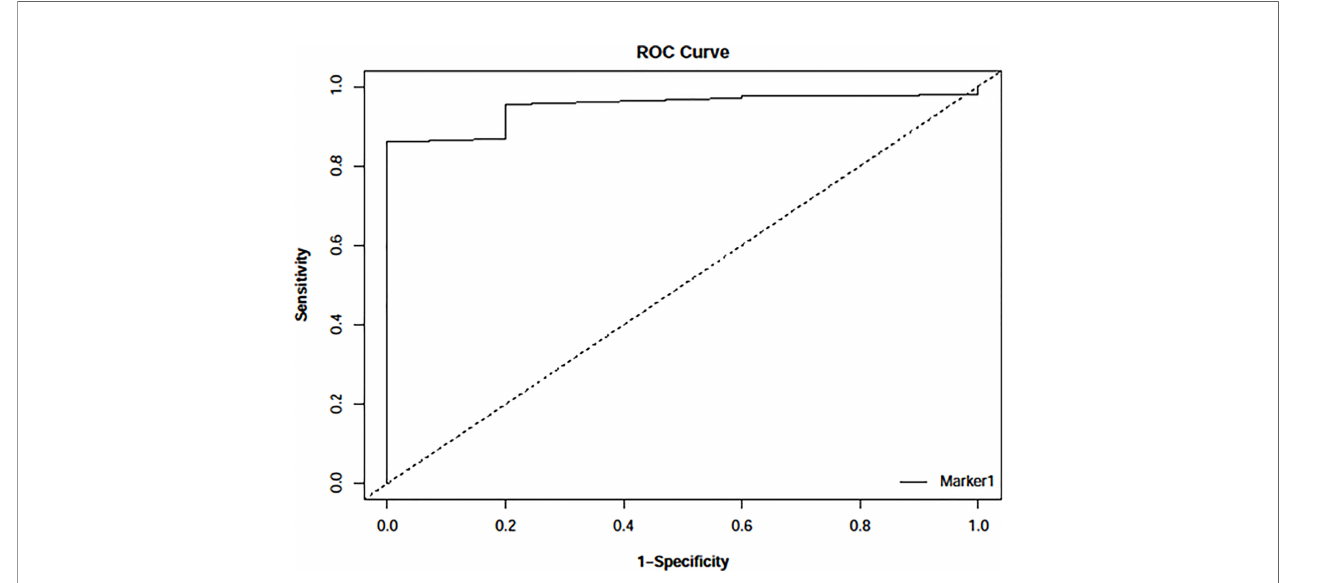
FIGURE 2 | Receiver operating characteristic (ROC) curve generated with easyROC (Goksuluk et al., 2016) after docking 243 decoys and 5 potent inhibitors against Pf TMPK using AutoDock Vina via PyRx version 0.8. The area under the curve (AUC) obtained was 0.94897 with a p-value of 9.776159e −